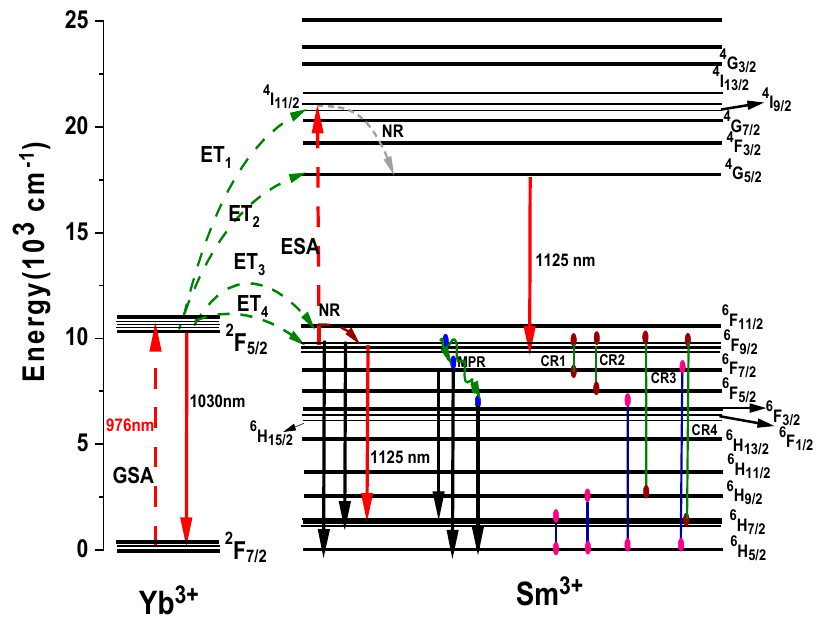
Figure 8. Energy-level diagrams of Sm 3+ and Yb 3+ observed in the NIR emission transitions under 976 nm excitation and possible energy transfer processes.